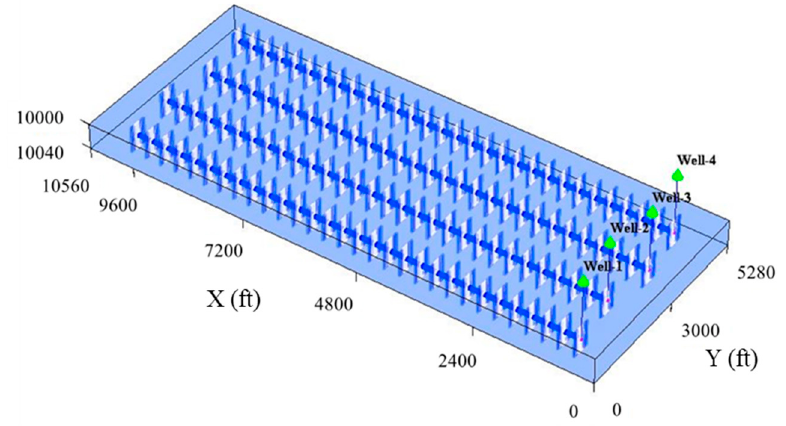
Figure 1. Simulation model for the field-scale study including 4 horizontal wells. Table 1. Properties of reservoir and fracture from the Eagle Ford